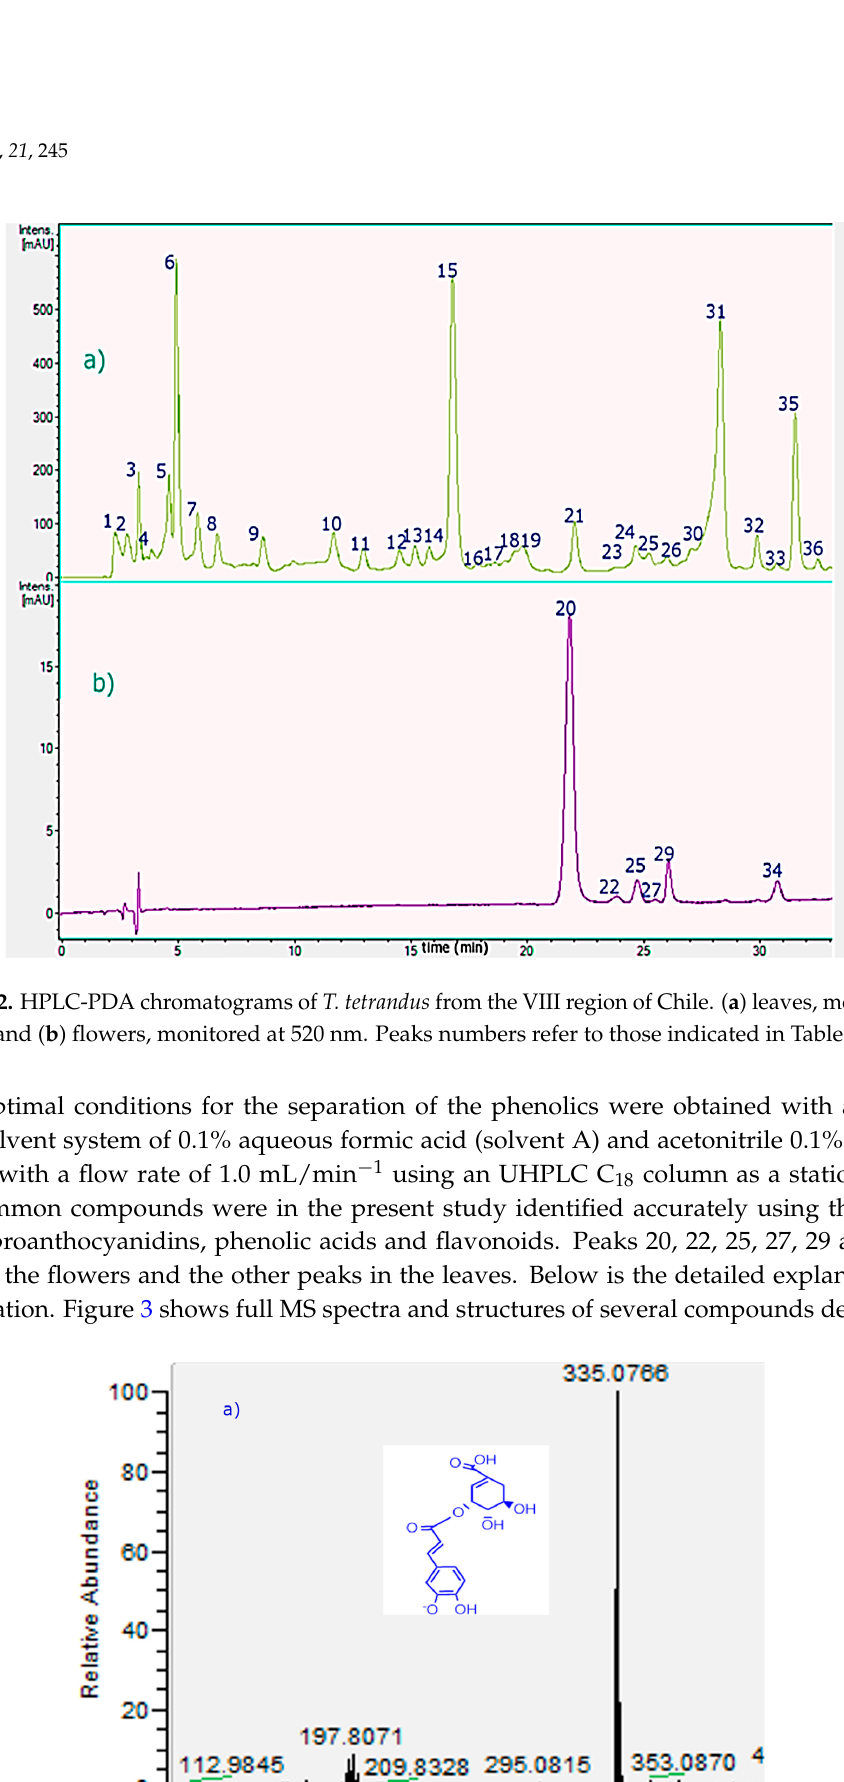
Figure 3. Cont. Figure 3. Cont.